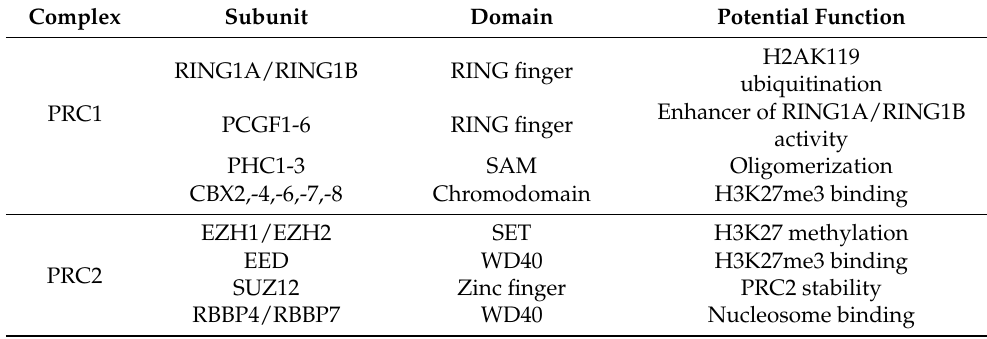
Table 2. The core components of PRC1 and PRC2 and their functions in chromatin organization